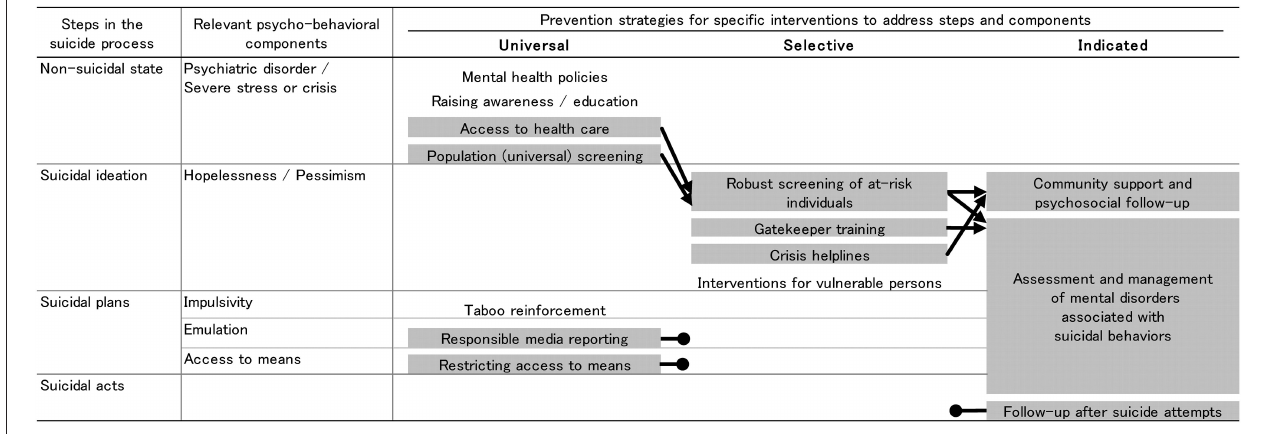
FIGURE 1 | Schematic diagram of suicide process and prevention strategies (22). Interventions highlighted in gray are supported by evidence of their efficacy in reducing suicide risk. A black arrow indicates a clear link to another intervention. A black circle indicates no known link to other interventions. The interventions at each point in the suicide process are expected to involve people at stages closer to